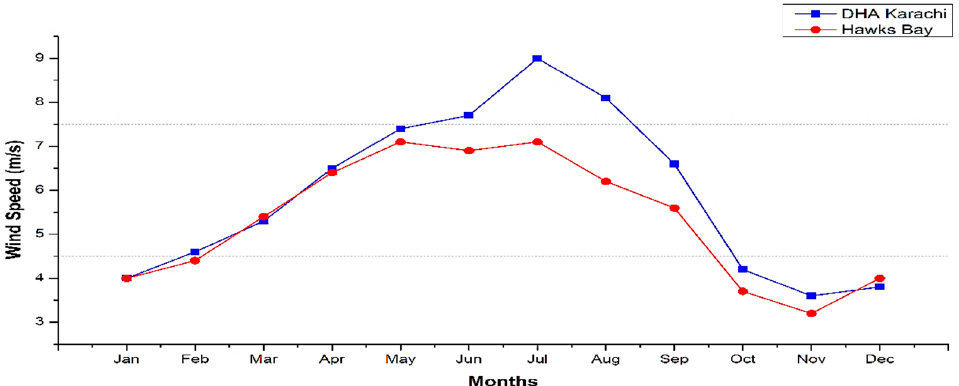
Figure 9 . Annual Wind Speed for Zone 1 (Karachi).